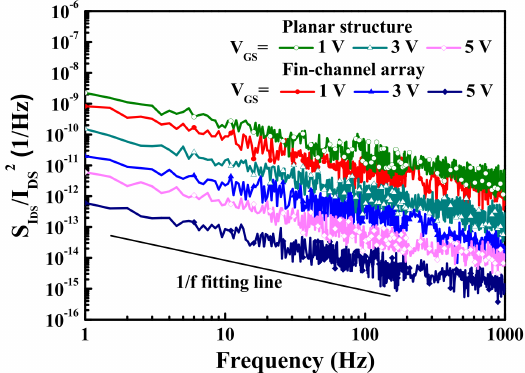
Figure 5. Frequency-dependent normalized noise power density spectra of double-channel MOSHEMTs operating at drain–source voltage of 1